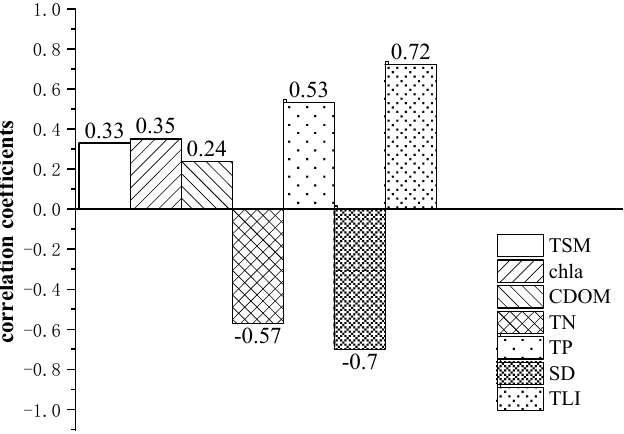
Figure 6. The correlation coefficient between FUI and water quality parameters. Formulas (12)–(17) were used to calculate the TLI value of the water body at the sampling point in August 2018 (N = 93). The FUI algorithm of 4.1 was applied to Sentinel-2 images with synchronous sampling time, and the relationship between Sentinel-2-derived FUI and TLI was established (Figure 7a). During this period, the FUI value of the water in the study area was between 11 and 20, and the water was yellow-green to yellow-brown. The TLI value was between 25 and 52, which was in a medium trophic status. It can be seen that the FUI value reached a high level when the estuary water with high sediment content was in an oligotrophic state. However, on the whole, the measured TLI value is strongly correlated with Sentinel-2-derived FUI, and the FUI index increases with the increase in TLI value. When the water is in an oligotrophic state, the water is green. When the water changes from poor nutrition to medium nutrition, it becomes yellow. The color index of eutrophic water is the highest (FUI ≥ 20). When the FUI range is between 11 and 15, one-third of the water body is in a state of poor nutrition and two–thirds of the water body is in a state of medium nutrition. When FUI = 19, the TLI value is between 33 and 50, but the distribution is relatively dispersed. When FUI = 20, there is a eutrophic water body, but the whole is still in the middle trophic state. This is because the content of non-algae suspended solids in estuarine water is the greatest, and the water composition is complex. It is easy to evaluate the degree of eutrophication based on FUI because of different water